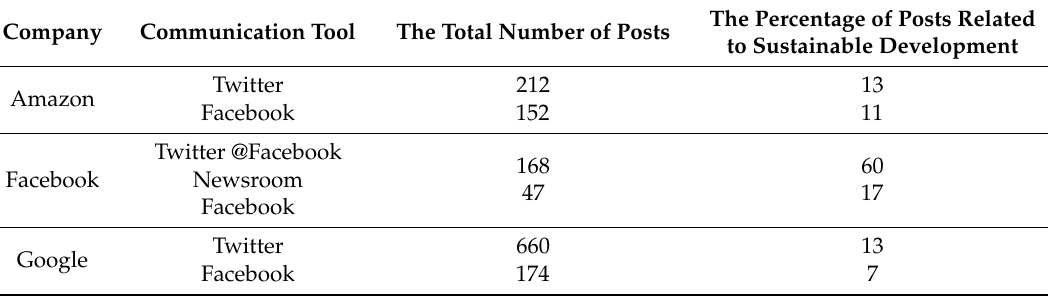
Table 4. Results of social media messages’